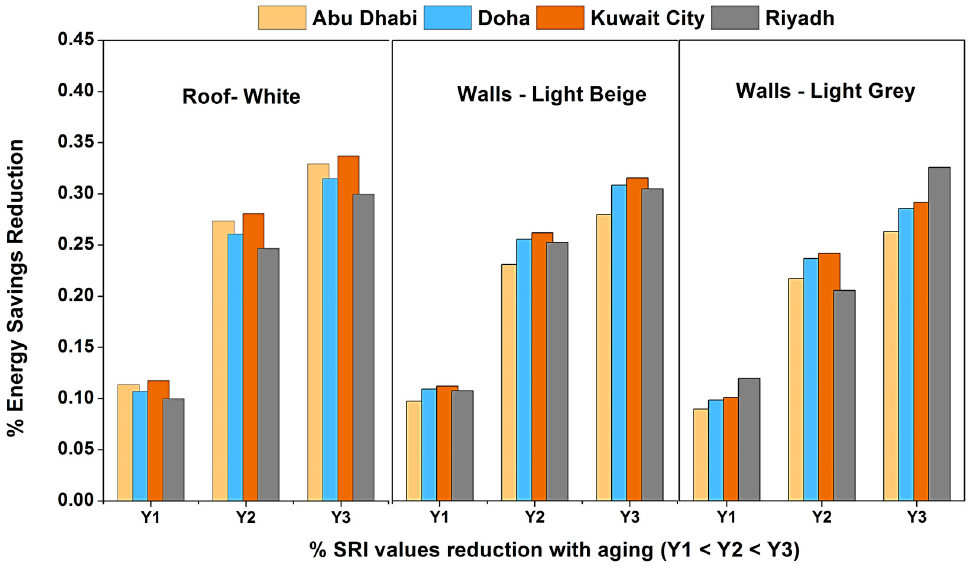
Figure 22. Percentage reduction in Energy savings with aging at various locations.